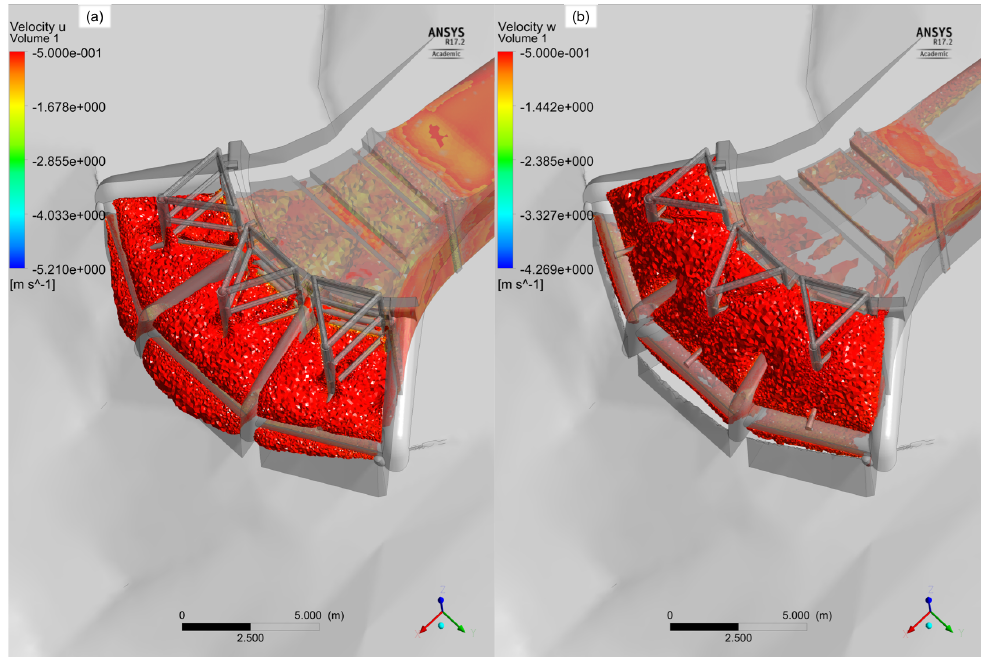
Figure 7. Example analysis of the final trash rack option E 03—volume analysis for u ≤ − 0.5 m · s − 1 ( a )